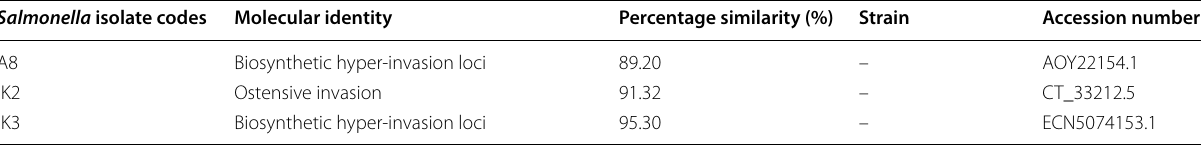
A, Akure; IK, Ikare